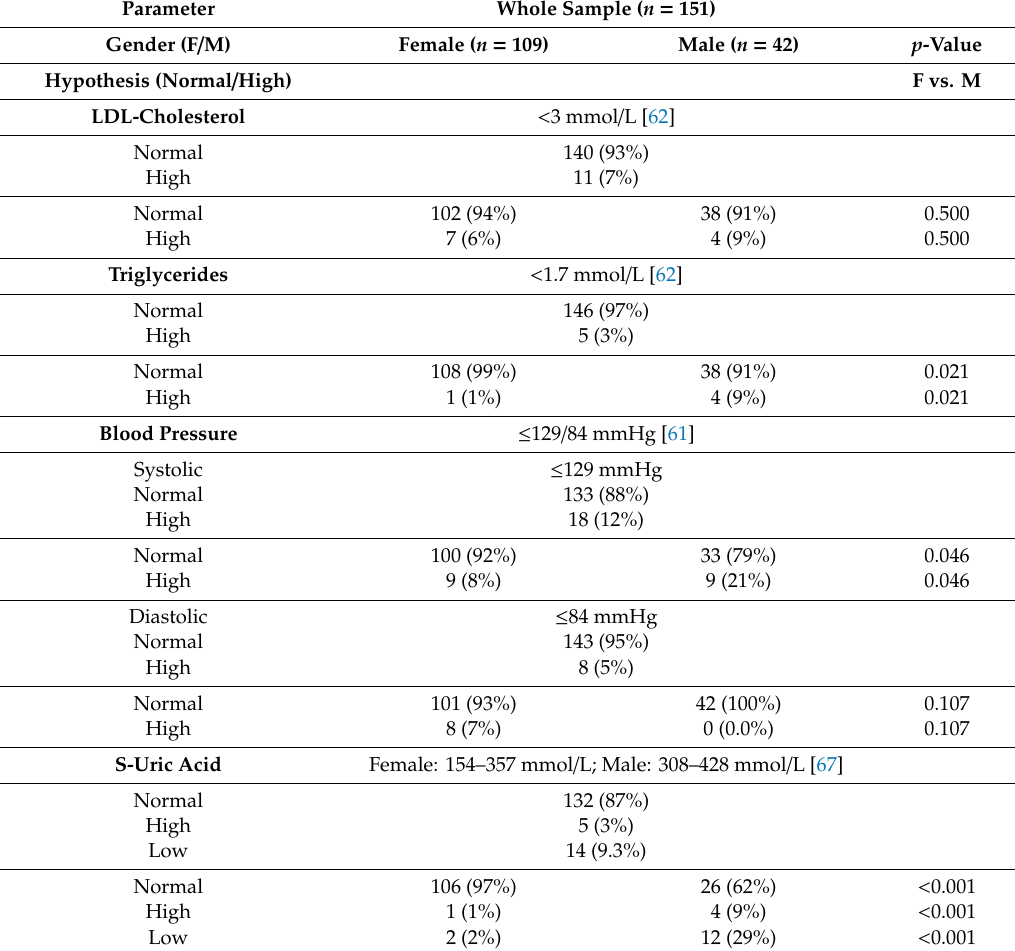
Table 6. Percentage of participants in the WFPB lifestyle program (0.5–10 years), by gender, achieving recommendations [61,62,67,68] for cardiovascular risk factors and safety